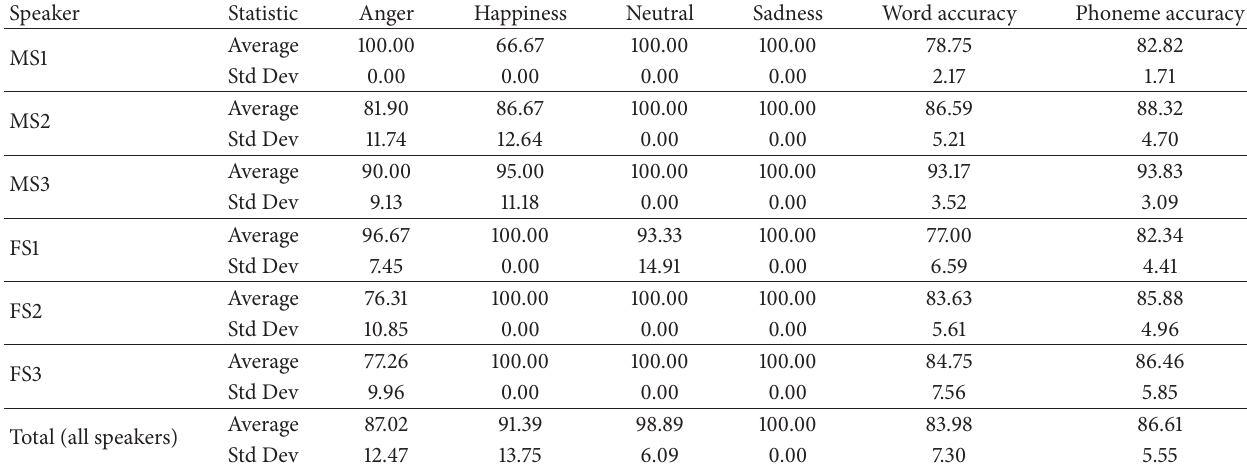
Table 9: Average classification performance of the ASR system for speech and emotion recognition (individual speakers from the speech corpus) across five